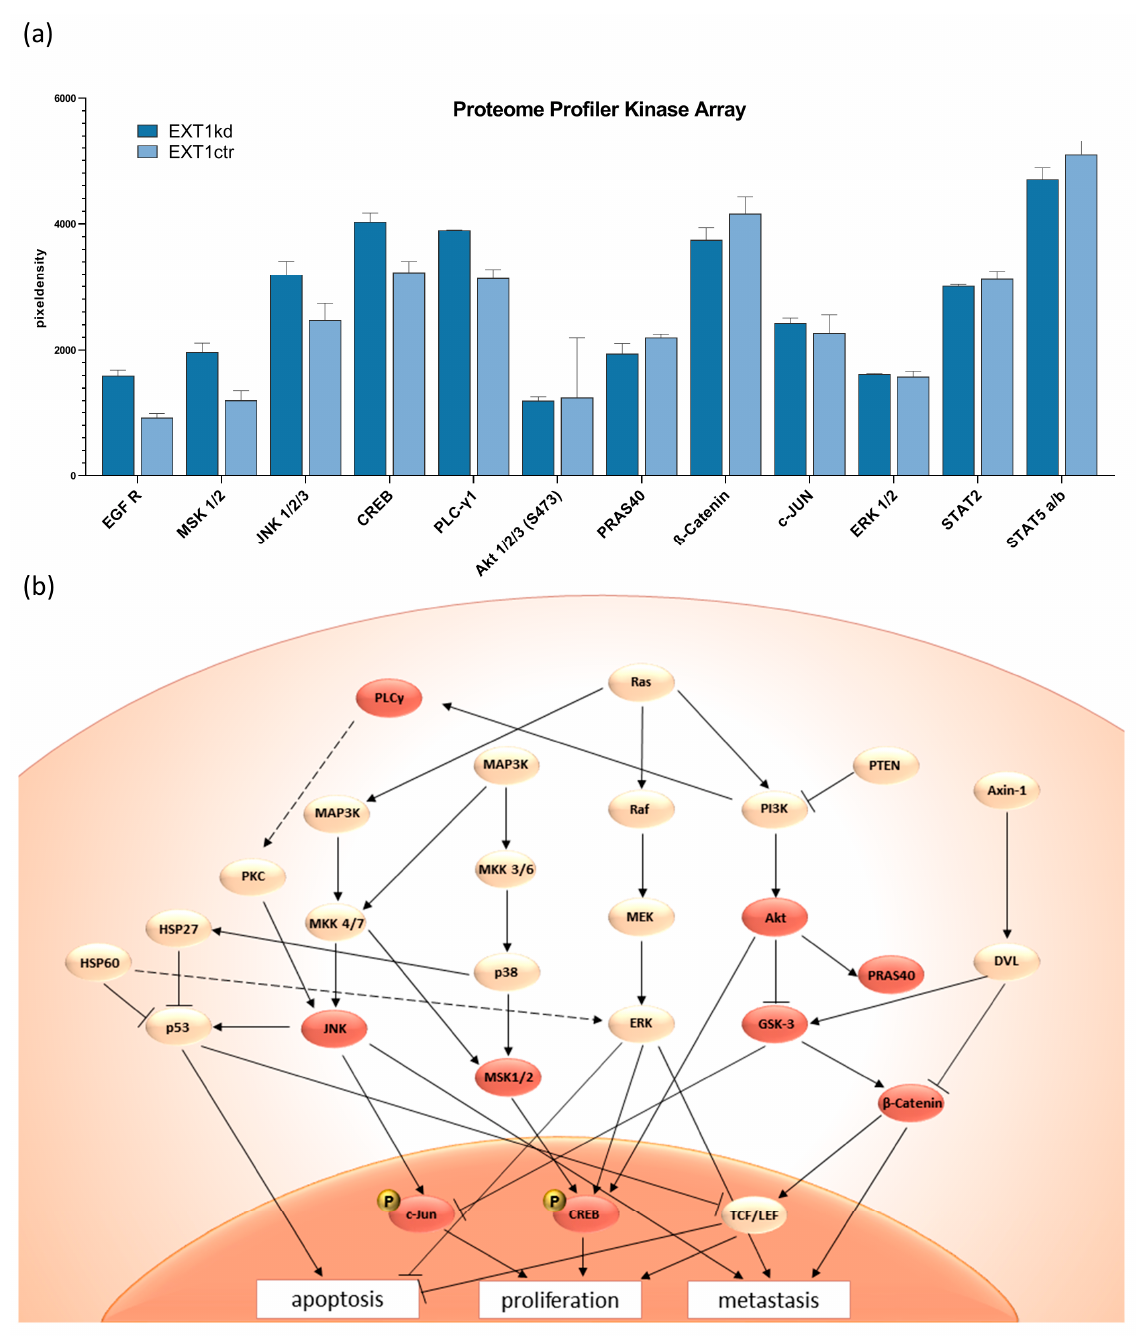
Figure 4. Selected data of a proteome kinase profiler array ( a ) comparing untreated MV3 EXT1kd and MV3 EXT1ctr cells, given as relative units. ( b ) Scheme of important signaling pathways following EGFR activity and selection for potential interference to affect resistance. Reddish highlighted areas are the deregulated kinases that lead to repressed apoptosis, as well as higher proliferation and